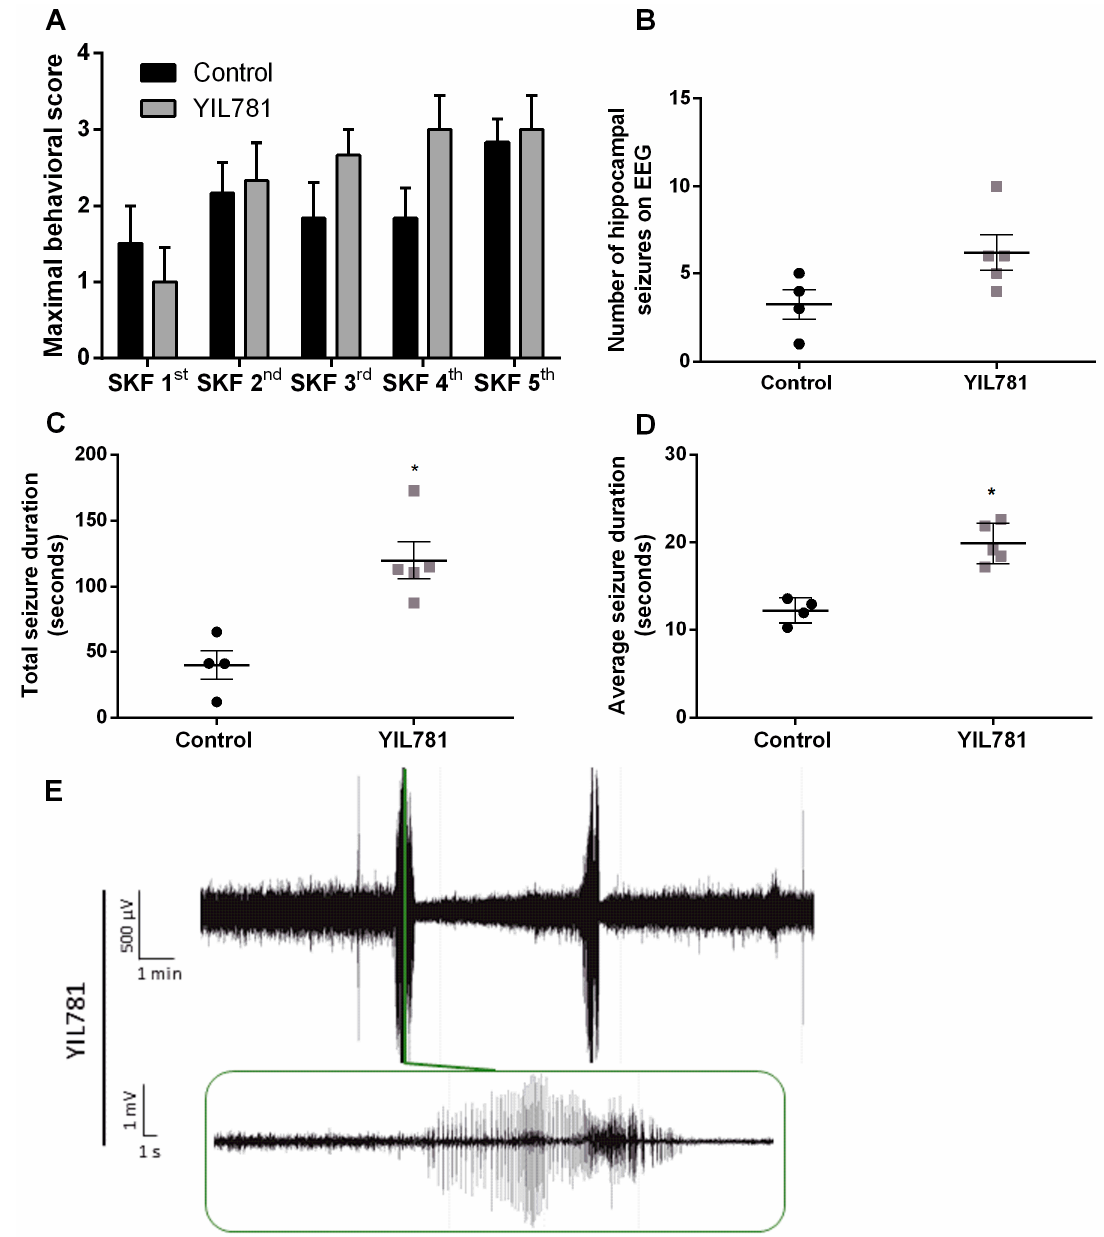
Figure 4. The e ff ect of YIL781 on SKF81297 induced seizures. ( A ) Maximal behavioral scores obtained by YIL781-treated ( n = 6) and control ( n = 6) animals. Two-way RM ANOVA (interaction p > 0.05, F(4,40) = 1.035; time p < 0.05, F(4,40) = 3.597; treatment p > 0.05, F(1,10) = 3.071). ( B ) The number of hippocampal seizures on EEG did not di ff er between YIL781-treated mice ( n = 4) and saline-treated control mice ( n = 5). Mann–Whitney test ( p = 0.056; Mann–Whitney U = 2.000). ( C ) Total seizure duration was higher in YIL781 treated mice ( n = 5) compared to saline-treated control mice ( n = 4). Mann–Whitney test ( p < 0.05; Mann–Whitney U = 0.0). ( D ) YIL781-treated mice ( n = 5) have higher average seizure durations compared to saline-treated control mice ( n = 4). Mann–Whitney test ( p < 0.05; Mann–Whitney U = 0.0). ( E ) Representative traces of YIL781-treated mouse already experiencing several seizures during SKF 3rd. 0.3 Hz high-pass, 60 Hz low-pass, and 50 Hz power line filters were applied. Data are presented as mean ± SEM. *, p < 0.05. EEG, electro-encephalography; µV, microvolt; mV, millivolt; min, minute; s, second; SKF, SKF81297.